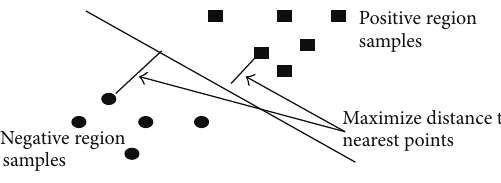
Figure 5: SVM classification.